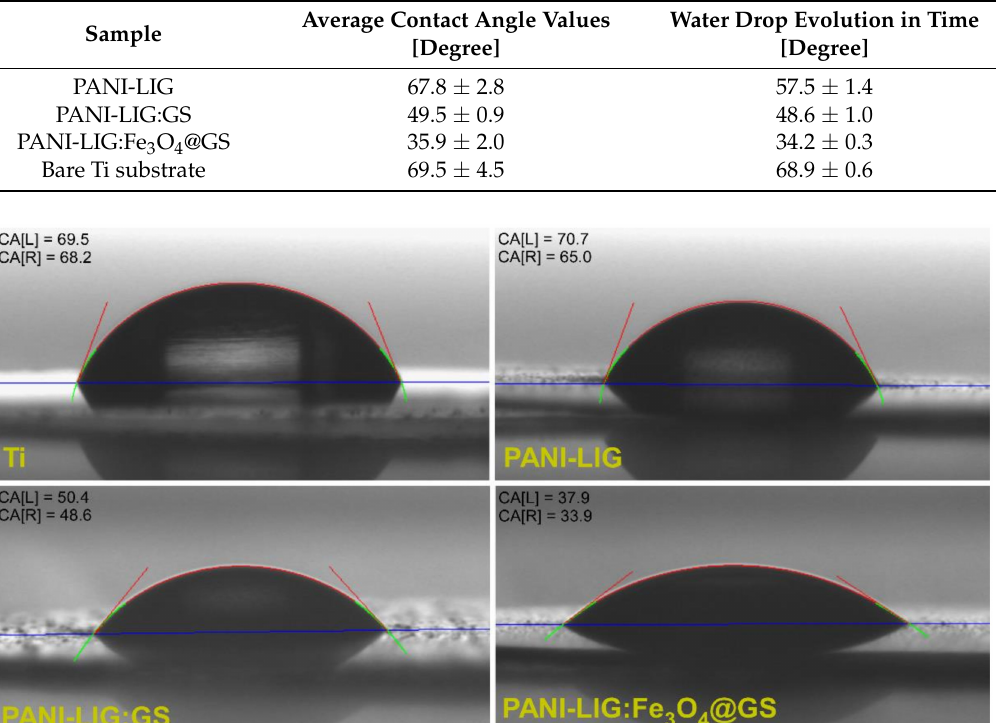
Figure 5. Representative images of water droplets on bare Ti and Ti with PANI-LIG based coatings deposited by matrix-assisted pulsed laser evaporation